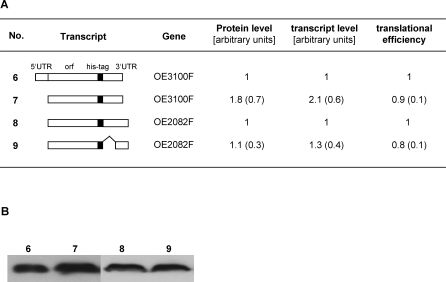
Characterization of the In Vivo Function of UTRs in H. salinarum Using Gene Fusions(A) The constructs that were integrated into the genome of H. salinarum are shown schematically. Protein and transcript levels were determined using a anti-his6-tag antibody and qRT-PCR, respectively. The translational efficiencies were calculated by dividing the protein levels by the transcript levels. Three biological replicates were performed and the average values and standard deviations (in parentheses) were calculated.(B) Representative western blot analysis of cultures carrying the constructs shown in (A).